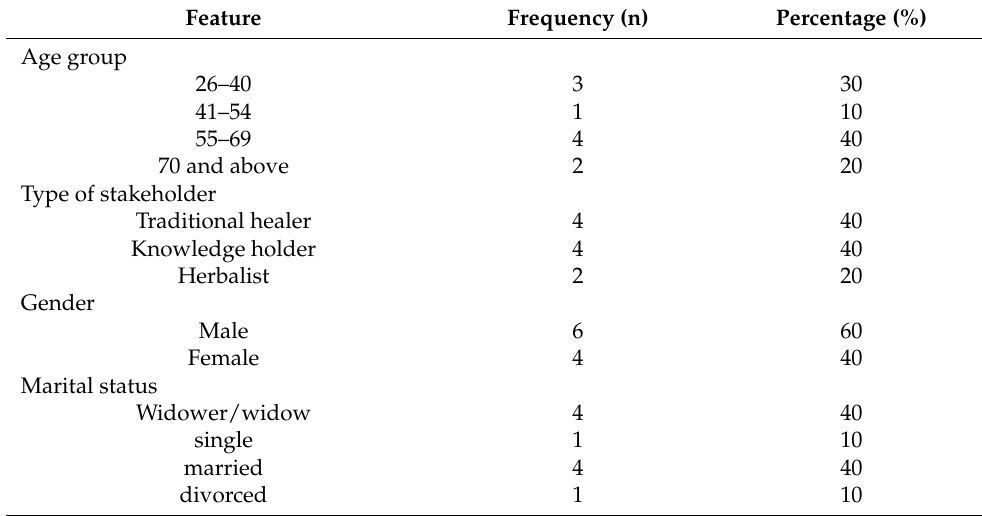
Table 1. Demographic characteristics of the participants in two (2) communities of Bushbuckridge local municipality, Mpumalanga province, South